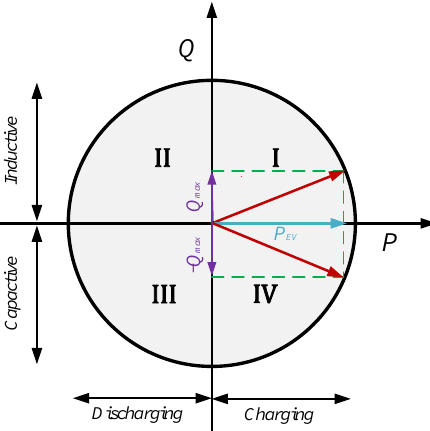
Figure 3. EV charging/discharging